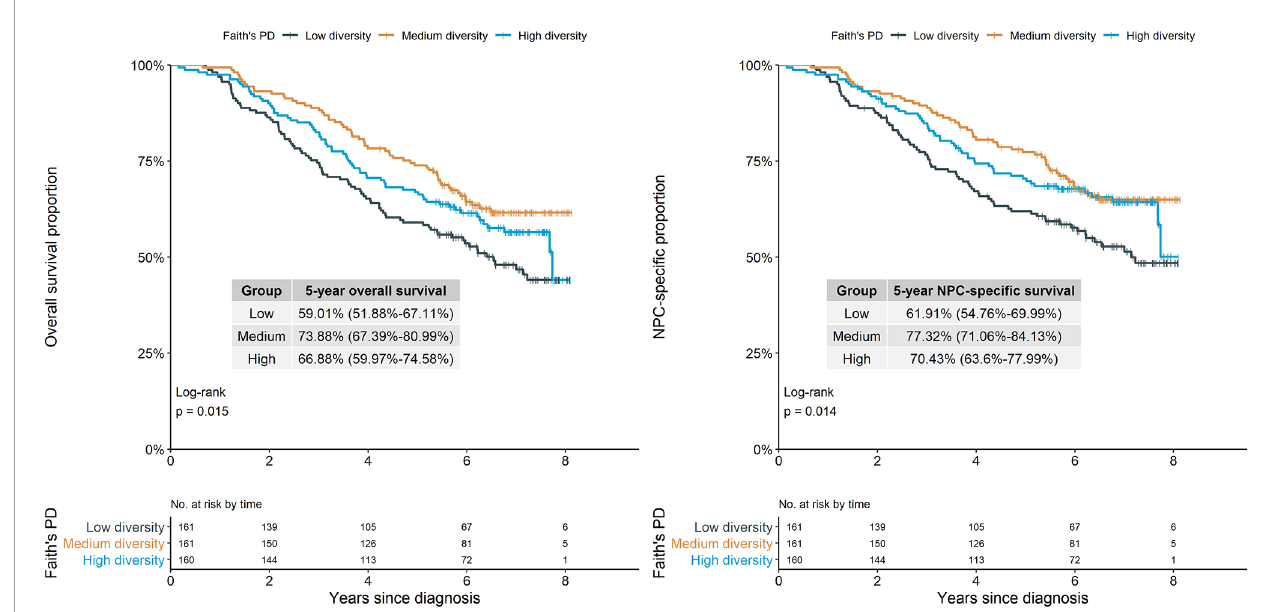
FIGURE 1 | Survival proportion of NPC cases by alpha diversity (Faith ’ s phylogenetic diversity). Log-rank test showed different Faith ’ s PD groups had signi fi cantly different overall survival and NPC-speci fi c survival proportion ( p =0.015 and p =0.014). NPC, nasopharyngeal carcinoma; Faith ’ s PD, Faith ’ s phylogenetic diversity.